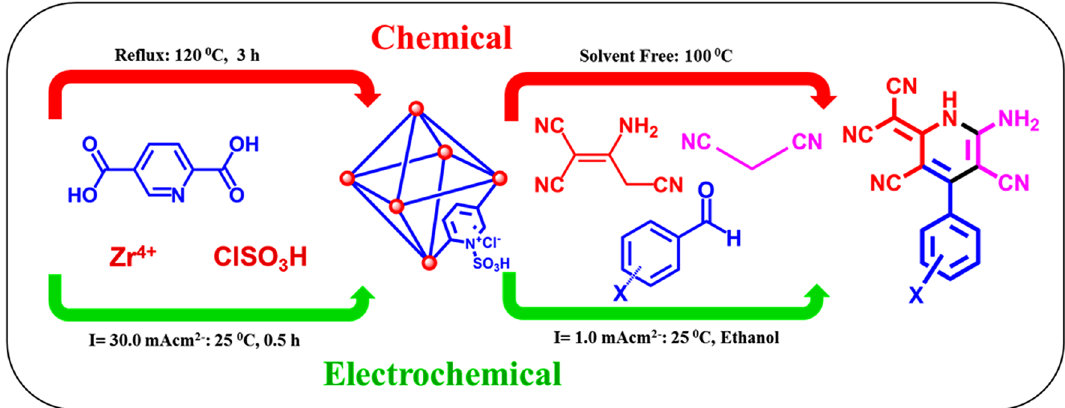
Figure 2. Synthesis of dicyanomethylene pyridines using [Zr-UiO-66-PDC-SO 3 H]Cl as a catalyst by chemical (A) and electrochemical (B)